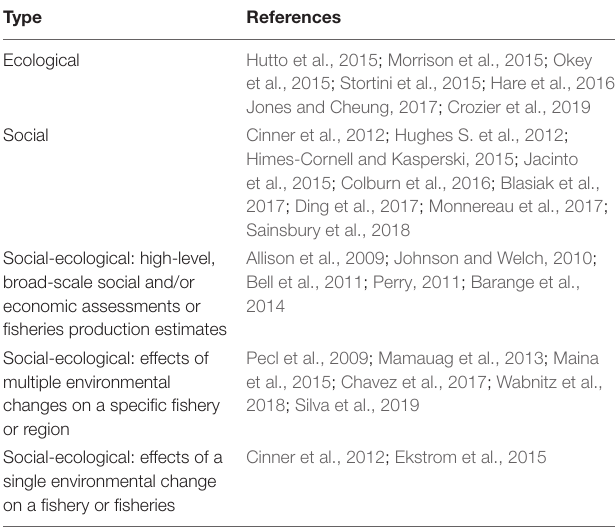
TABLE 1 | Published fisheries-oriented CVAs by scope and